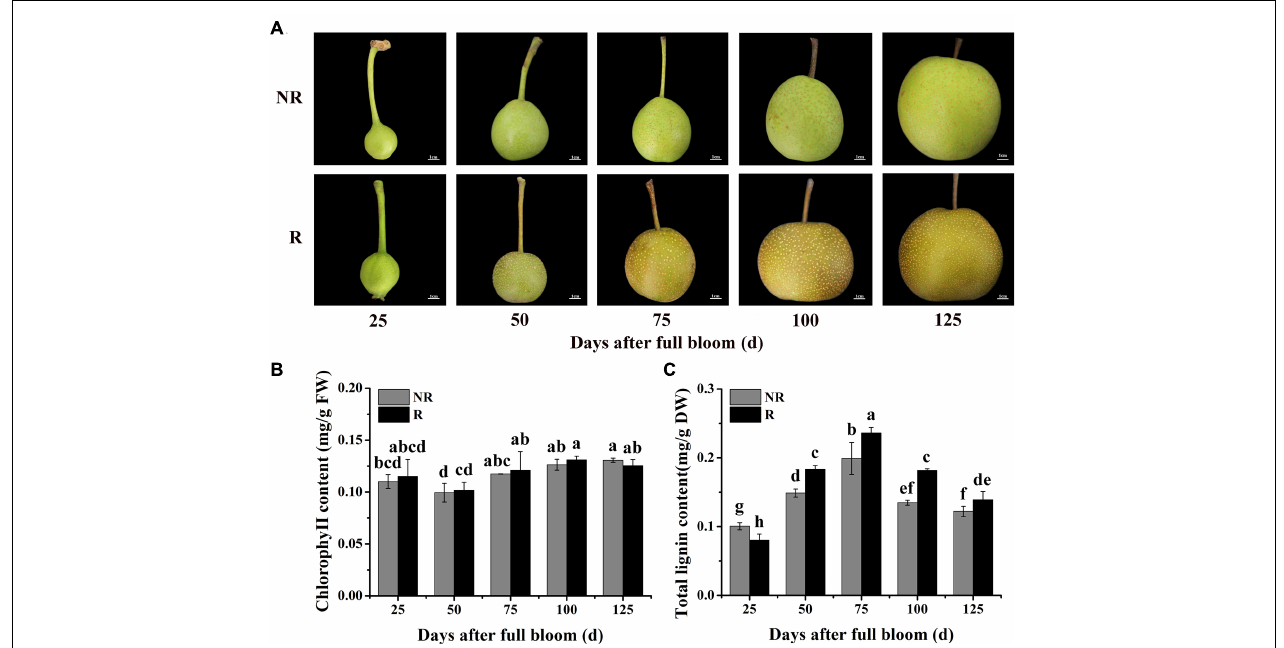
FIGURE 1 | Changes in skin color and pigment contents in F 1 plants from the cross between ‘Niitaka’ (russet skin pear cultivar, NTK) and ‘Dangshansu’ (non-russet skin pear cultivar, DSS). (A) Color development in pear skin of F 1 progeny from 25 to 125 days after full bloom. (B) Chlorophyll and (C) lignin contents in pear skin of F 1 progeny from 25 to 125 days after full bloom. NR: non-russet skin fruits; R: russet skin fruits. Different lowercase letters above bars mean significant differences between NR and R groups by Tukey’s multiple range tests ( p < 0.05).